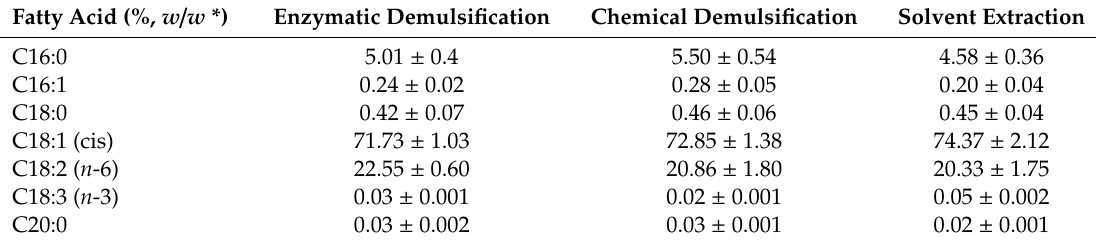
* Relative percentage of the total fatty acid groups. The absence of letters indicates no statistical di ff erence ( p < 0.05) in the row for each fatty acid analyzed.